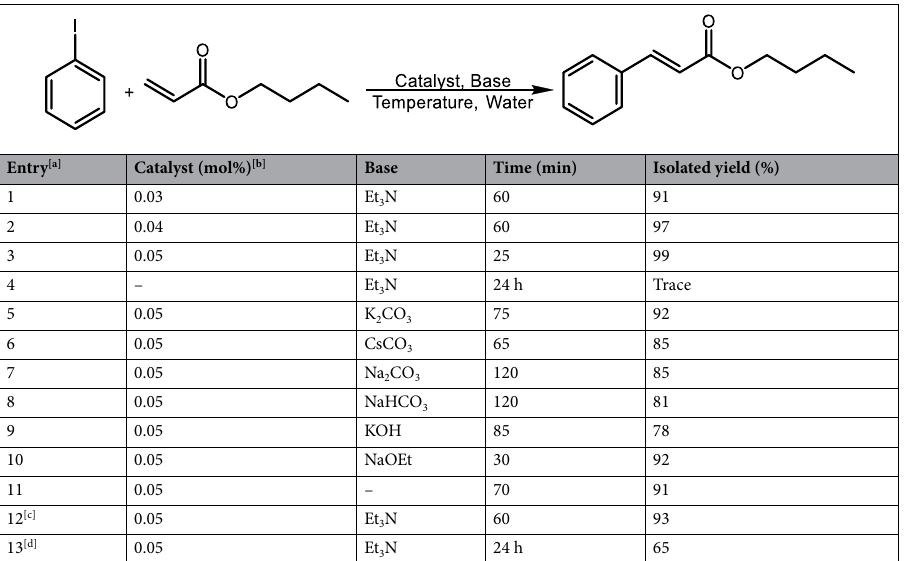
Table 1. Mizoroki–Heck reaction between iodobenzene and n -butyl acrylate catalyzed by γ-Fe 2 O 3 @MBD/ Pd-Co using water. [a] Reaction conditions: iodobenzene (1 mmol), n-butyl acrylate (1.3 mmol), base